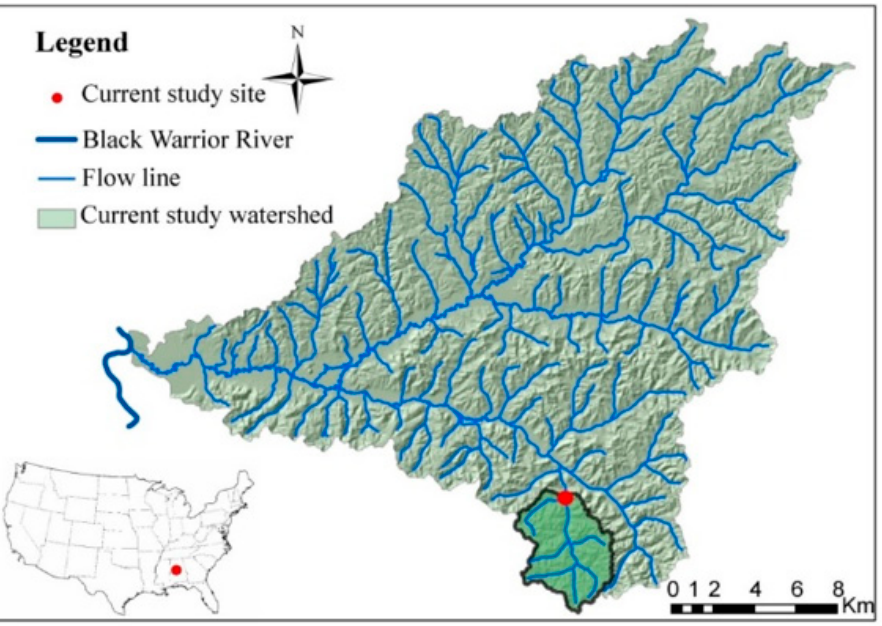
Figure 1. A map of the study area and sampling site. Streams are indicated by blue lines. The watershed boundary of the Mayfield Creek is indicated by black lines, and the sampling site is denoted by a red dot.